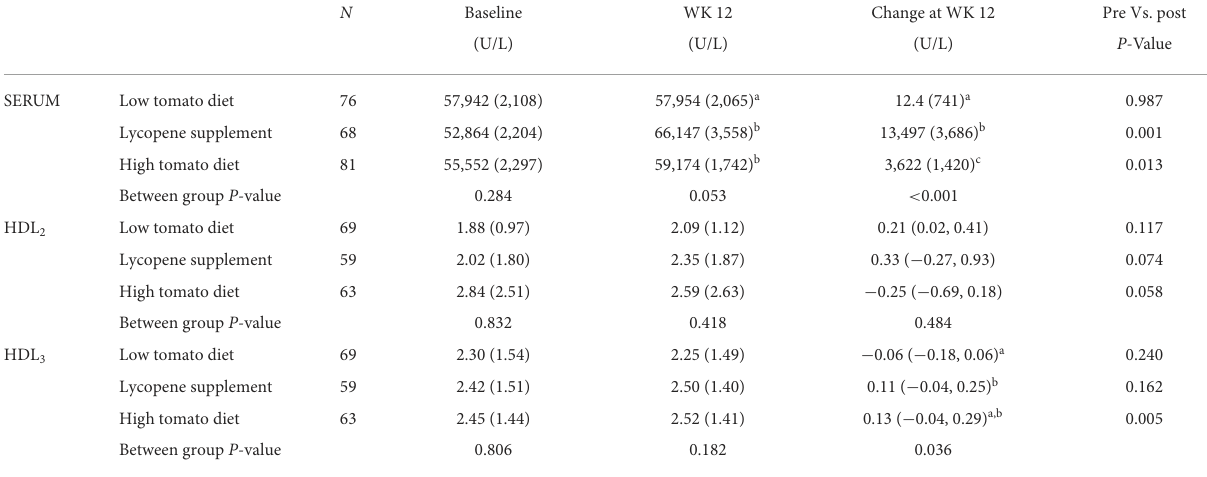
TABLE 4 PON-1 activity in serum, HDL 2 , and HDL 3 following 12-week intervention with either a low tomato diet, lycopene supplement, or high tomato